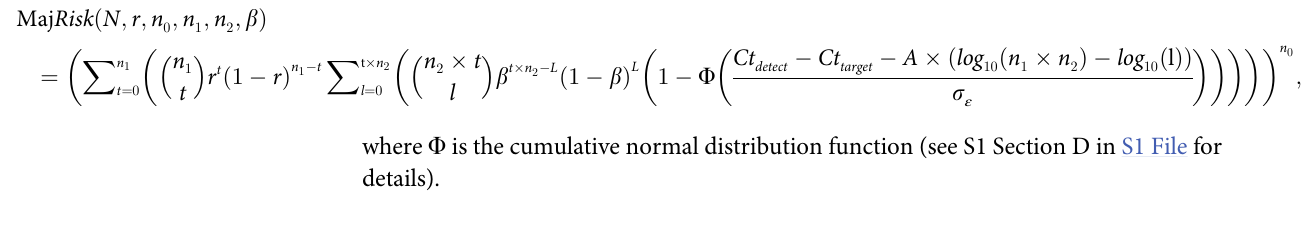
detection of infected leaves per tree (1 − β ) is the percentage of leaves on a tree with a defined amount or copy number of the viroid. We define a target threshold for the Ct value ( Ct ) target that is lower than the detection Ct (denoted Ct ), which corresponds to the minimal Ct detect value that can be obtained for leaves that do not contain the viroid. The prevalence corre- sponds to the percentage of trees in an orchard with a unit level of infection above the unit level detection limit. The confidence level is the probability of detecting the viroid in a field with a given prevalence. Default values for the key parameters are summarized in Table 1. The default value for β = 0.67 is similar to that used by the Ministry of Agriculture in New Zealand [10]. The default values for the PCR parameters that we use reflect the estimates that were